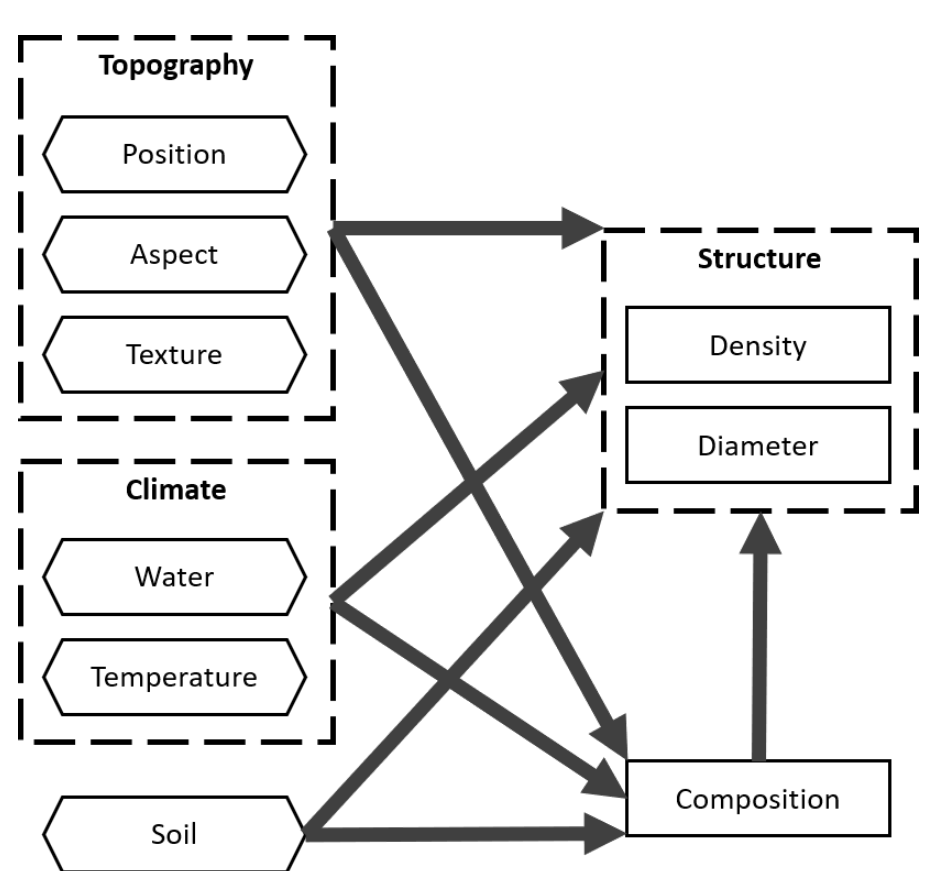
Figure 2. Conceptual model used at the beginning of structural equation modeling. This model represents our initial hypothesis that topography, climate, and soil directly drive variation in structure and composition, and indirectly drive variation in structure through composition. Dashed boxes represent conceptual groupings of variables, solid boxes represent measured variables, hexagons represent composites of multiple measured variables, and arrows indicate causal relationships in the data. Variables are described in Methods: Identifying drivers of variability and details for all variables are provided in Table A1. Correlation between all environmental variables was included in the model, but for simplicity were not shown in the diagram.